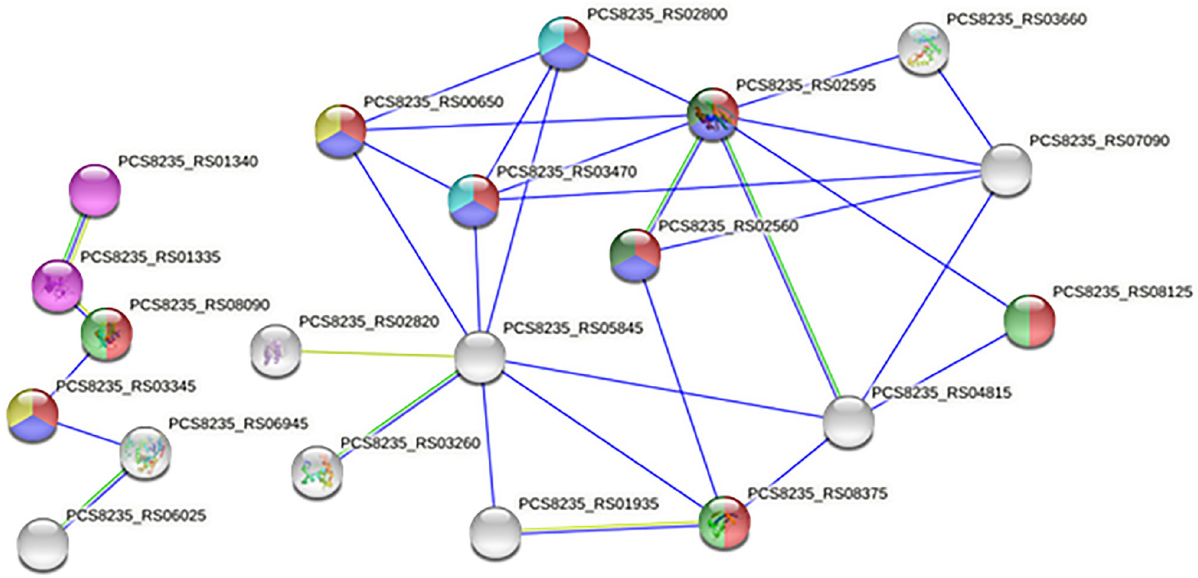
Fig 5. String results of PPI revealed several HPs that interact with pneumococcal vaccine antigen A and Ribosomal silencing factor; PCS8235_RS05845 and PCS8235_RS02595 have the highest